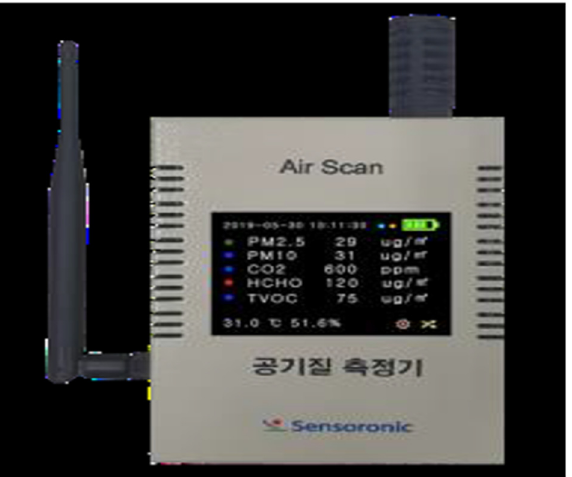
Figure 2. AirScan Device used for monitoring the Indoor Air Pollutant level.